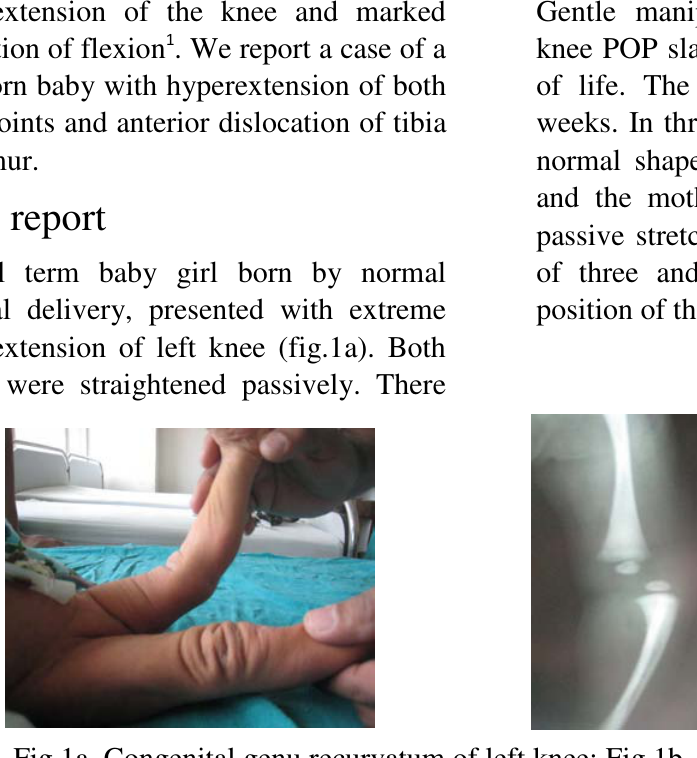
Fig.1a. Congenital genu recurvatum of left knee; Fig.1b. radiograph of the